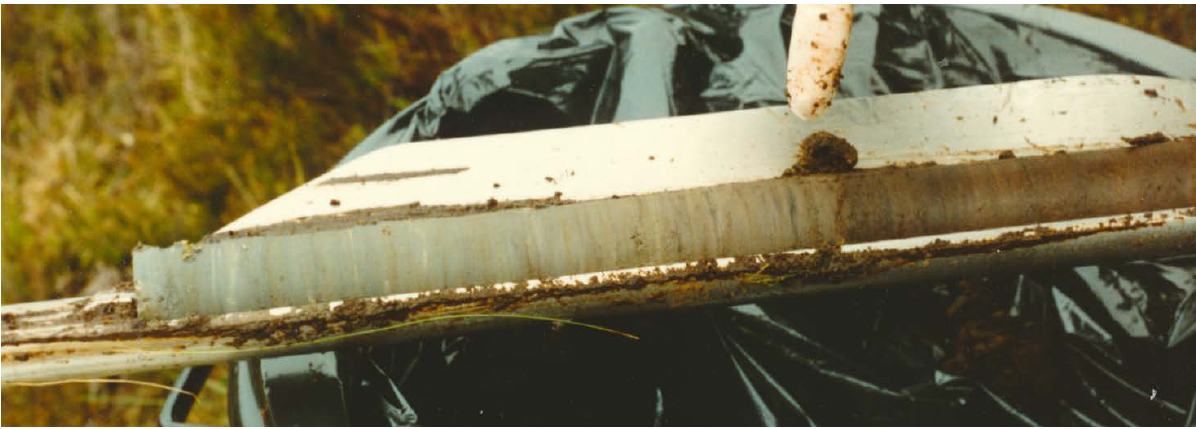
Figure 3. Typical core from the experiment region. Dark brown peat to the right (uppermost), tenacious grey clay to the left (lowermost). This was the third 50-cm core (1.0 to 1.5 m) in a vertical